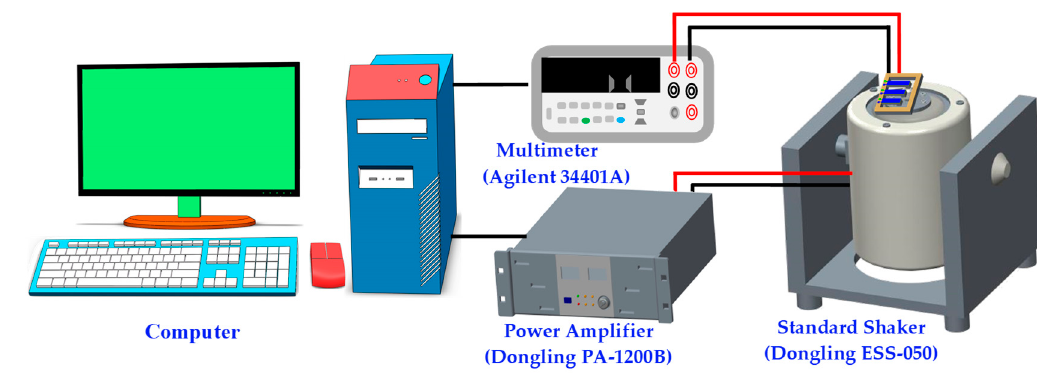
Figure 9. The testing system of the energy harvester.